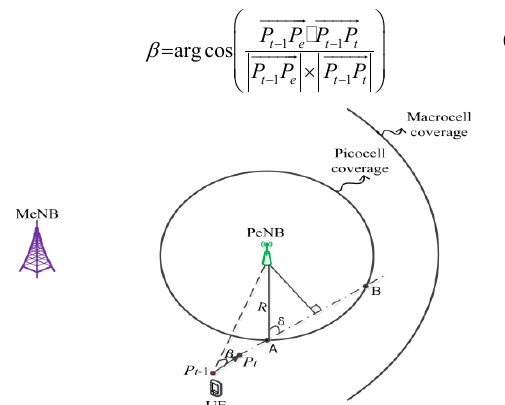
Fig. 2. The measurement of the movement direction of